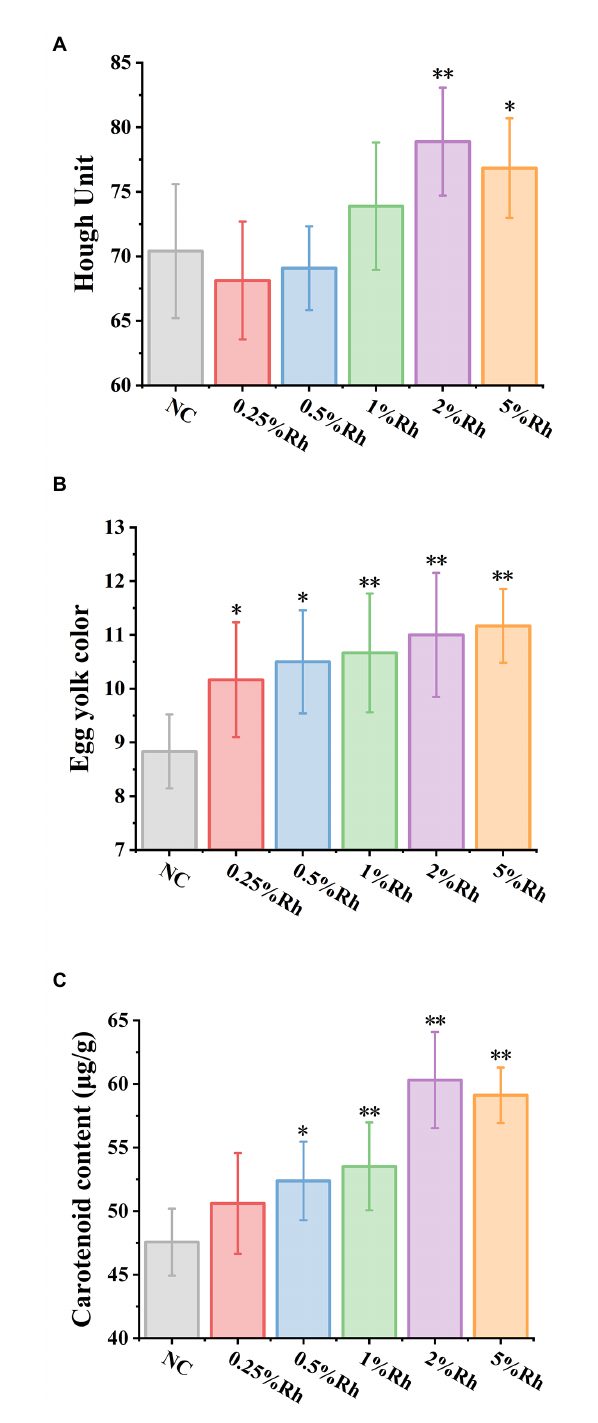
FIGURE 4 The effect of Rhodotorula glutinis fermented in TWW on egg quality. (A) Hough unit; (B) egg yolk color; (C) carotenoids content. *indicates significant differences compared with NC group ( p < 0.05); **indicates extremely significant differences compared with NC group ( p < 0.01). Values represent mean ± standard deviation ( n =